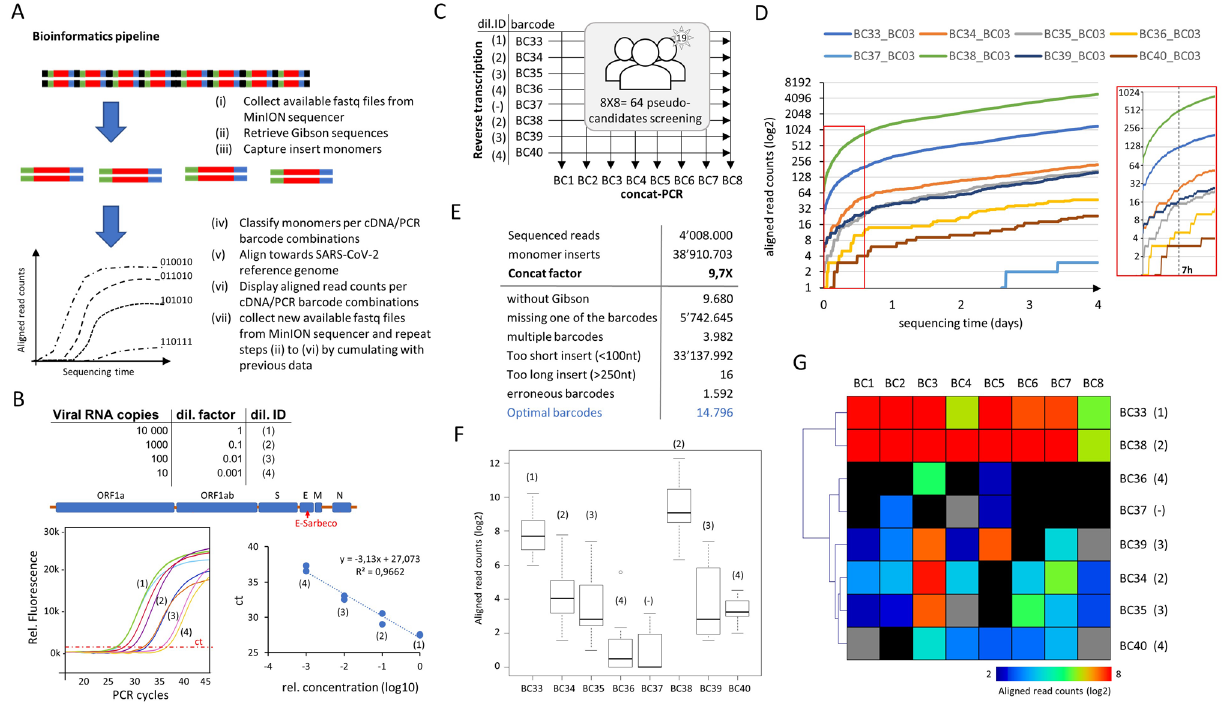
Figure 3. SARS-CoV-2 diagnostics assay with Nanopore DNA sequencing. ( A ) Scheme of the bioinformatics pipeline within RETIVAD. Long concatemer sequenced reads are computationally fragmented in monomers with the help of the Gibson sequence location. Monomers are stratified on the basis of flanking barcodes (cDNA and PCR incorporated barcodes) and aligned to the Covid-19 viral reference genome to verify its specificity. Considering that Oxford Nanopore instruments provide sequenced data during sequencing, the aforementioned steps are performed on real-time, such that the number of aligned read counts per candidate (defined by the combination of cDNA & PCR incorporated DNA barcodes) are assessed and displayed during the MinION sequencing process. ( B ) The synthetic SARS-CoV-2 RNA control sample (Twist Bioscience; Wuhan-Hu-1 strain) was subsequently diluted and used for reverse transcription and RT-qPCR assay targeting the E-Sarbeco viral region. ( C ) Reverse transcription assay scheme for 8 conditions corresponding to different viral RNA dilutions (dilution ID corresponding to that presented in ( B )) and targeting the E-Sarbeco region. Each of these reverse transcription assays are identified by the indicated molecular barcodes (BC33–BC40). Note that among them a sample devoid of viral RNA is also included (BC37). All 8 samples are pooled at the end of the assay and concat-PCR amplified with a set of other eight barcoded primers targeting the E-Sarbeco gene (BC1– BC8), providing a combinatorial barcoding strategy corresponding to 64 pseudo-candidates. ( D ) Real-time display illustrating the number of aligned read counts associated to the E-Sarbeco region per dual barcode combination (BC3 vs all cDNA barcodes) assessed during Nanopore sequencing. Inset: Zoom view highlighting that the first seven hours of DNA sequencing are sufficient to reveal read count differences between samples. ( E ) Summary of the bioinformatics pipeline assessed at the end of 4 days of DNA sequencing. Concatenation factor is inferred from the ratio between the number of detected monomers and the initial number of sequenced concatemers. Optimal barcodes correspond to the number of sequences presenting an optimal monomer length (> 100nt; < 250nt) and presenting both cDNA & PCR barcode sequences. ( F ) Boxplots illustrating the total aligned read counts associated to each cDNA barcode (BC33–BC40) and the different PCR barcodes. Each of the boxplots are labelled with their corresponding viral RNA dilution (dil.ID indicated in ( B )). ( G ) Heatmap illustrating the total aligned read counts associated to each cDNA barcode (BC33–BC40) and the different PCR barcodes (BC1–BC8). Note that ( F , G ) reveals a sensitivity of 100 viral copies, since the next RNA dilution condition appears in some cases at the same level of the negative